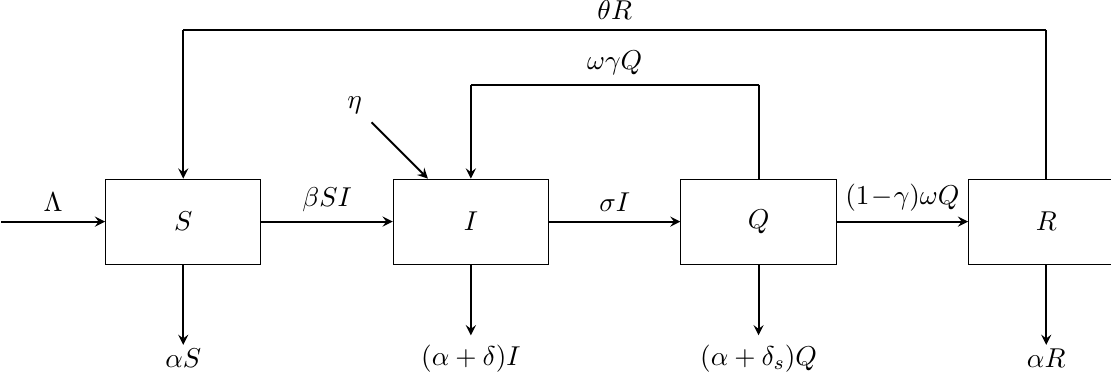
Fig. 1. Flow diagram for the transmission of the